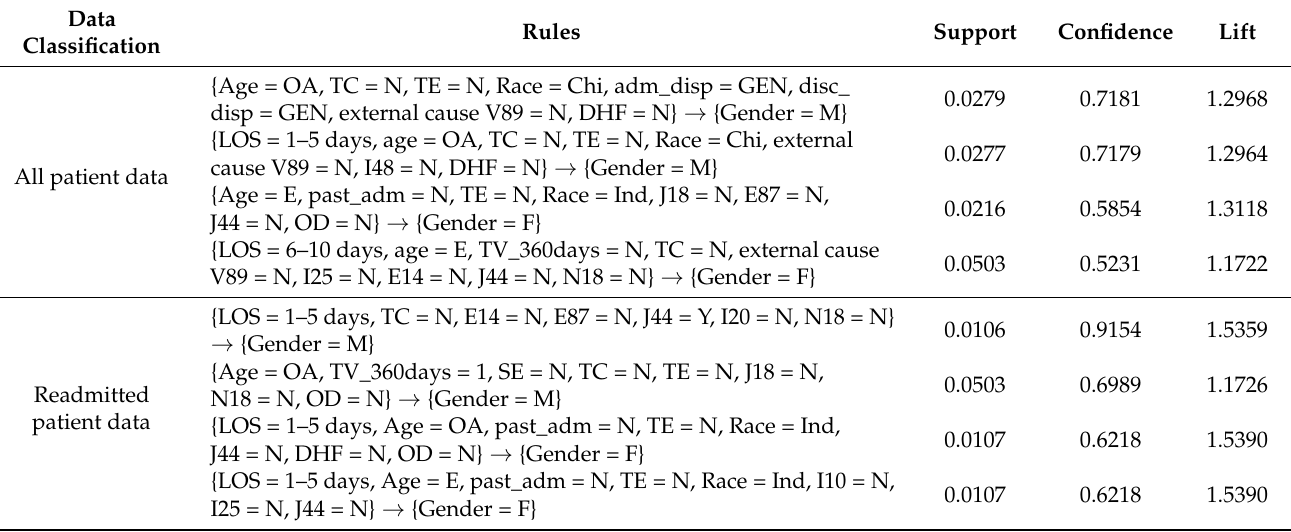
Table 4. Supervised association rule mined based on